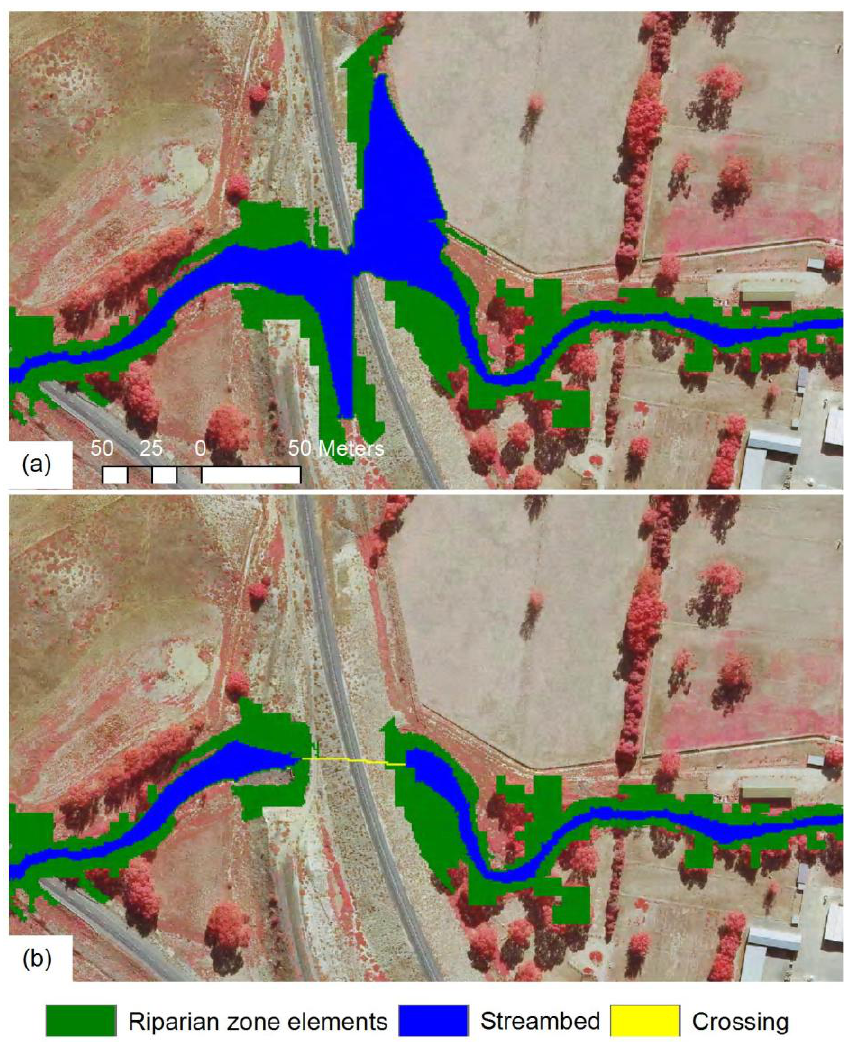
Figure 6. Example of streambed and riparian zone classification for an area with a railway crossing the stream. ( a ) Classification issues of the stream and riparian zone because of distinct elevation and slope changes caused by the railway crossing; ( b ) Improved classification where the railway crossing has been classified based on distinct elevation